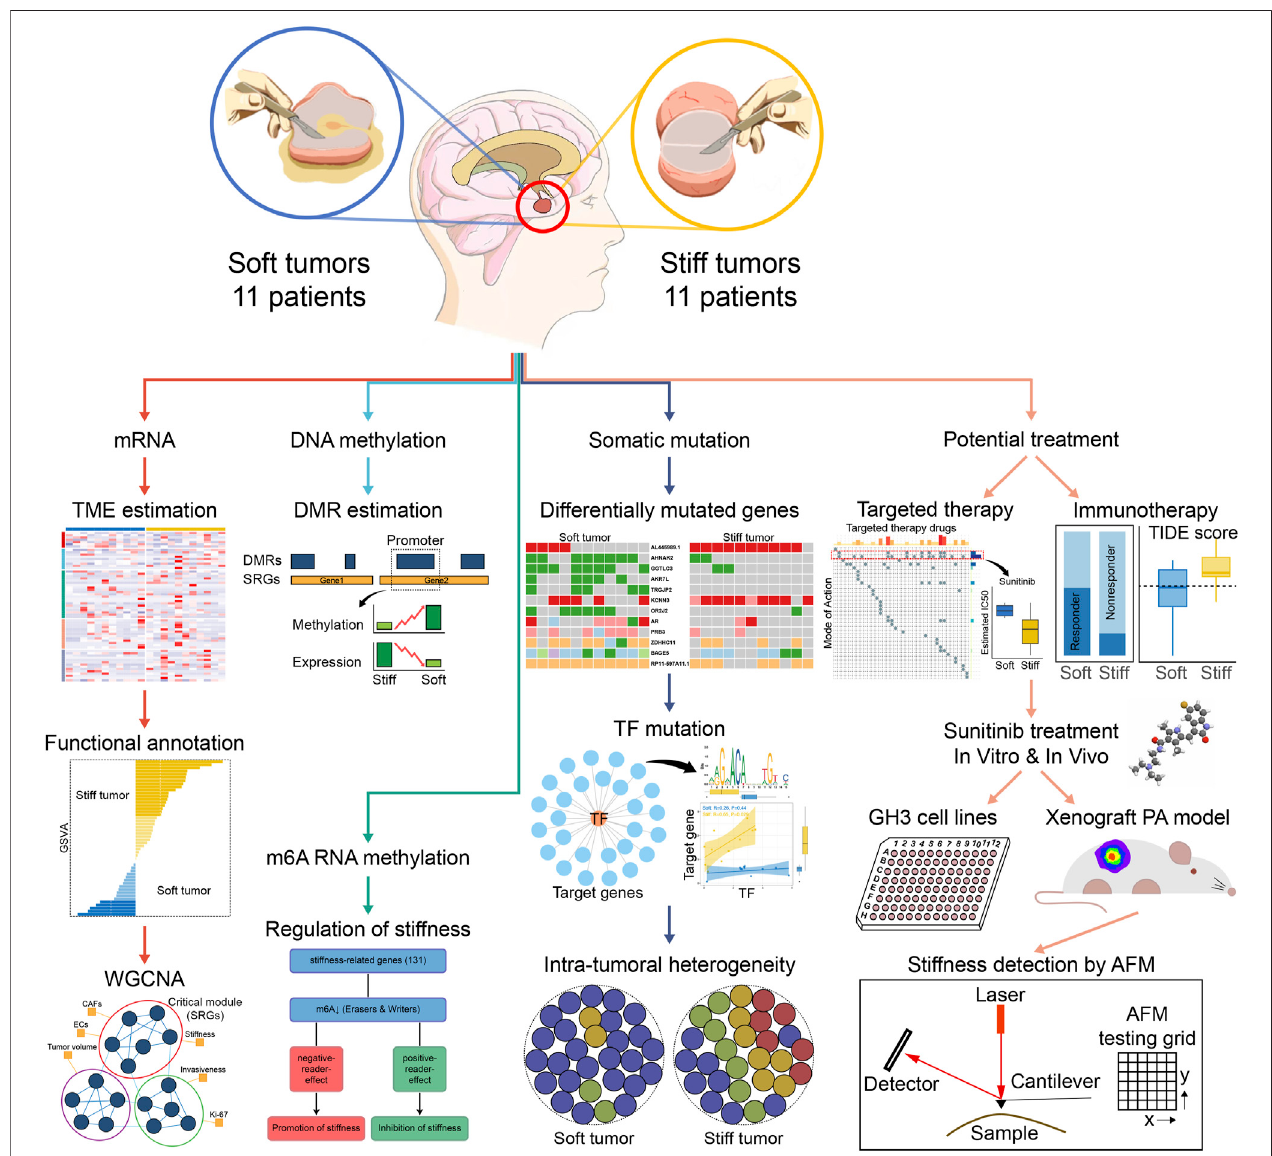
FIGURE 1 | The overall work fl ow of the integrated transcriptomic, genomic, and epigenomic pro fi ling analyses in this study.